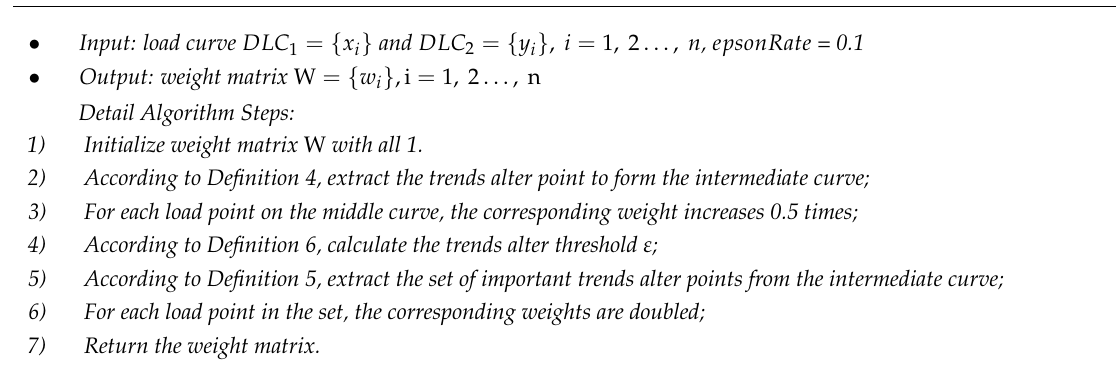
Algorithm 1. Weight Matrix Generation